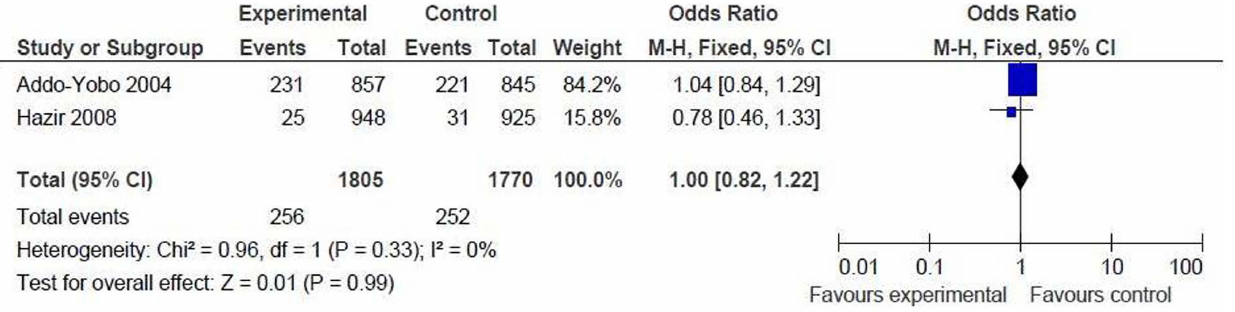
Figure 5. Secondary outcome measures [oral amoxicillin versus injectable antibiotics]. Proportions of children developing treatment failure or relapse by day 14.